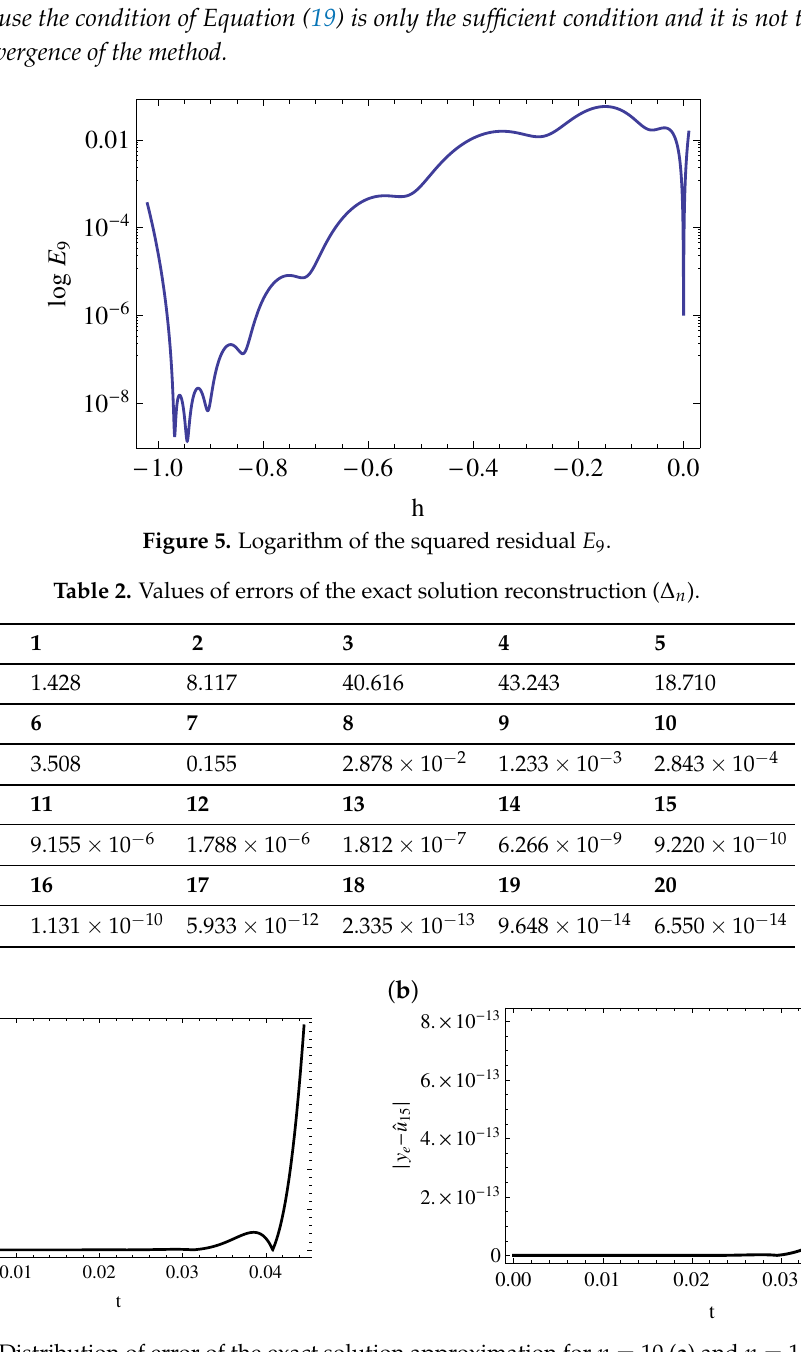
Figure 6. Distribution of error of the exact solution approximation for n = 10 ( a ) and n = 15 ( b